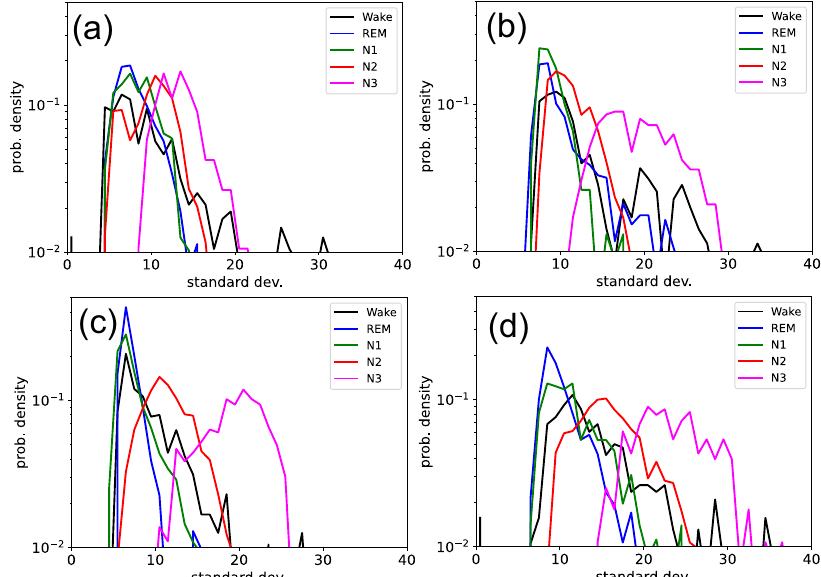
Fig. 2 Variation of hyper-parameter distributions among subjects. Distribution of the STD (one of the hyper-parameters considered in Fig. 3 of the main paper) in the different sleep stages, plotted individually for four subjects ( a – d ). The characteristic differences between the stages are visible for each individual, demonstrating the temporal heterogeneity of the process. At the same time, there exist signi fi cant differences between the individuals.